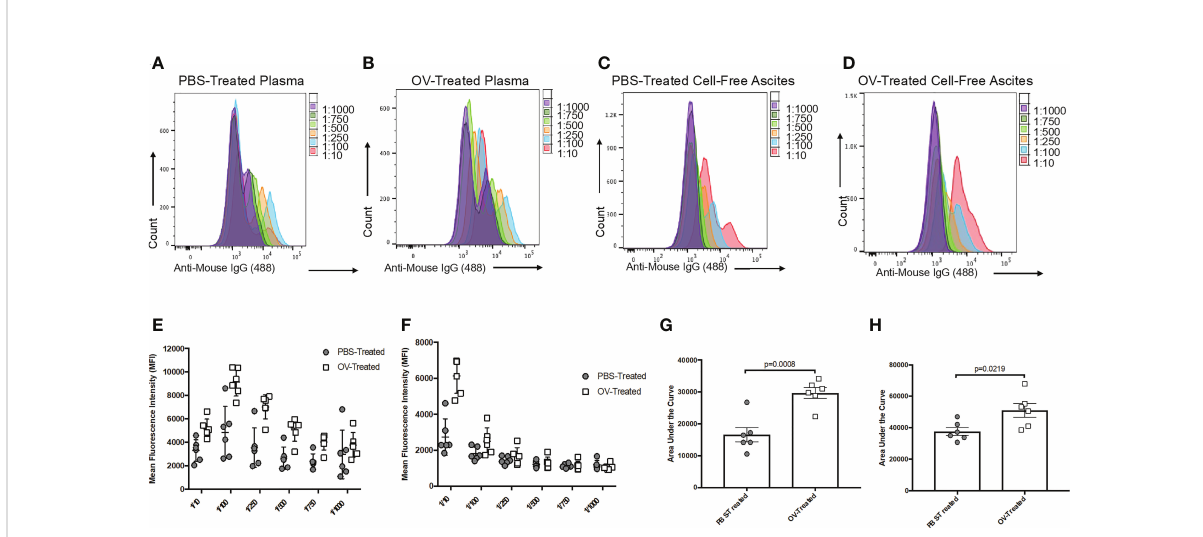
FIGURE 3 Optimization of the sample dilution scheme used to evaluate tumor-associated antibody responses following oncolytic virotherapy. Histogram overlays demonstrating the six-series dilution scheme of positive secondary antibody (anti-mouse IgG1 Alexa Fluor 488) signals from targeted ID8 cancer cells treated with serial dilutions of plasma from phosphate-buffered saline (PBS)-treated (A) or oncolytic virus (OV)-treated (B) , or serial dilutions of cell-free ascites fl uid from PBS-treated (C) or OV-treated (D) ID8 tumor-bearing mice. Curves were generated from the mean fl uorescence intensities (MFIs) of the Alexa Fluor 488 signals from targeted ID8 cells treated with serial dilutions of plasma (E) or cell-free ascites fl uid (F) collected 21 days following treatment of ID8 tumor-bearing mice with PBS or OV. Each data symbol represents a diluted sample from a unique biological replicate ( n =6 mice per group). Curves generated from the MFI for each biological replicate were used to calculate the area under the curve for comparison of tumor-associated antibodies from PBS-treated and OV-treated mice in the plasma (G) and cell-free ascites fl uid (H) . Statistical analysis was conducted using a two-tailed Student ’ s t-test. Statistical signi fi cance was de fi ned as P-values less than or equal to